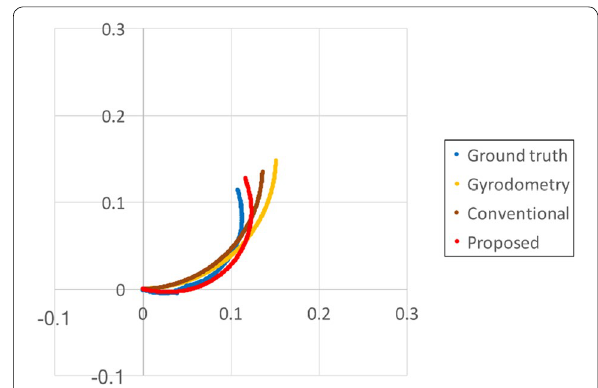
Fig. 17 Result of position estimation: slope angle is 15 ◦ , input veloc- ity is 5 cm/s, and input angular velocity is 20 ◦ /s